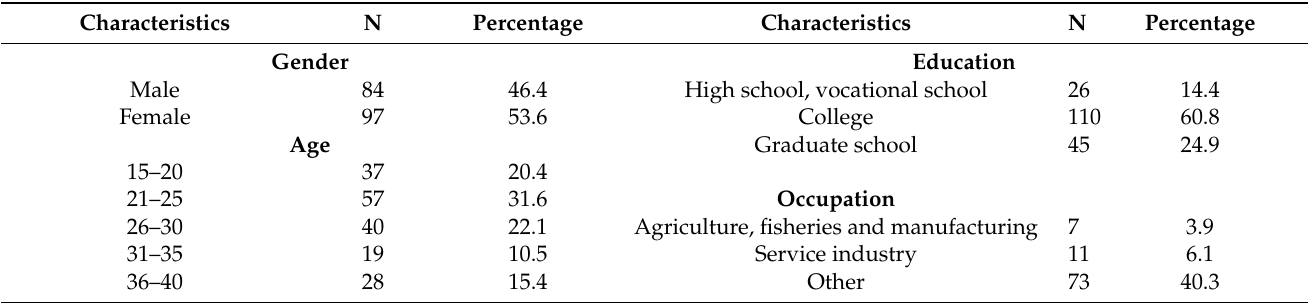
Table 1. Demographic characteristics ( n =